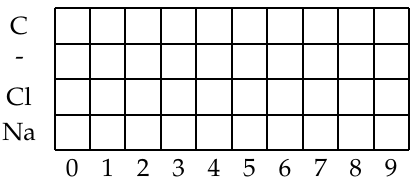
Figure 1. An example of the matrix prepared for the one-hot encoding for the dataset with the maximal SMILES symbol length of 10 and 5 unique symbols.